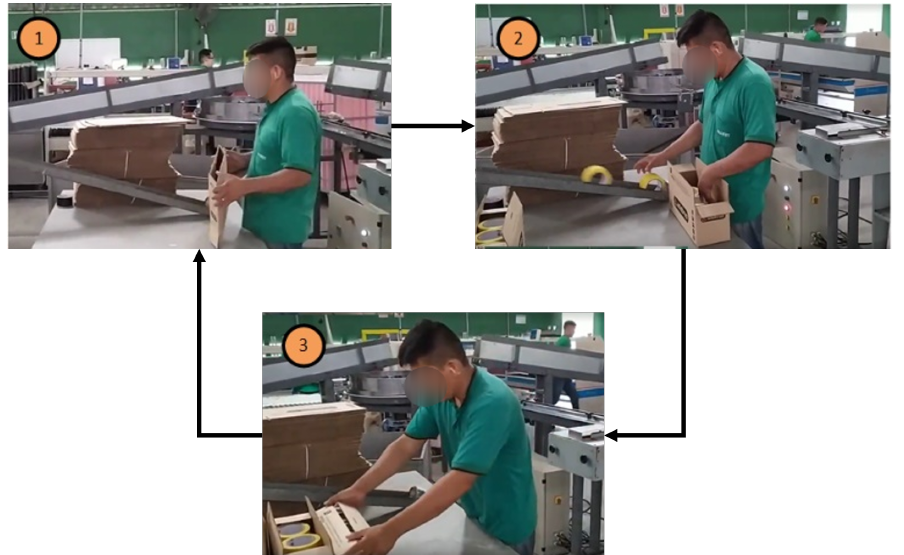
Figure 11. Manual adhesive tape packaging operation.